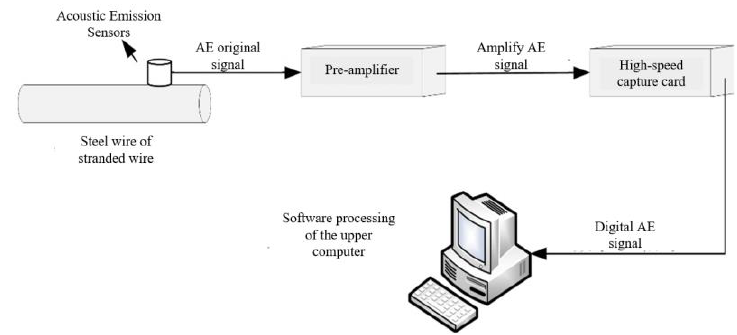
Figure 5. Steel strand acoustic emission monitoring system.